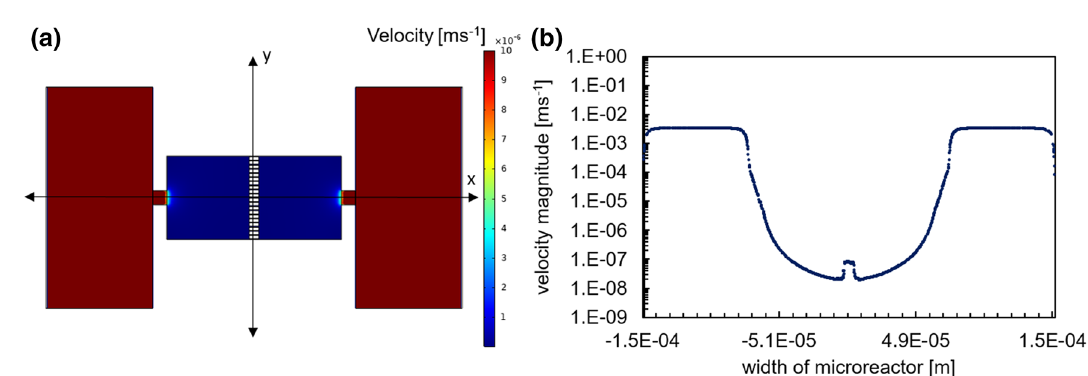
Figure 5. ( a ) Distribution map of the velocity magnitude at steady state, and ( b ) profile of the velocity magnitude along line y = 0 with the center of the growth chamber as